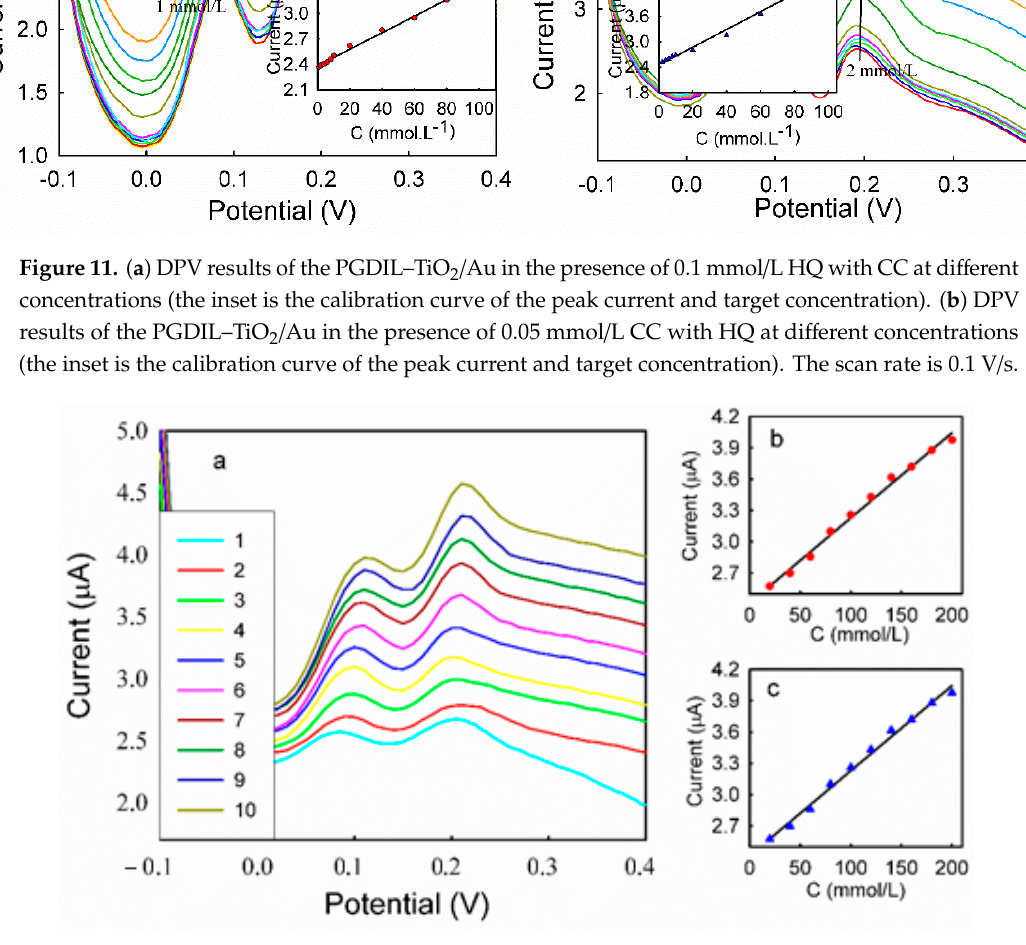
Table 3. The composition of the binary mixture of CC and HQ.